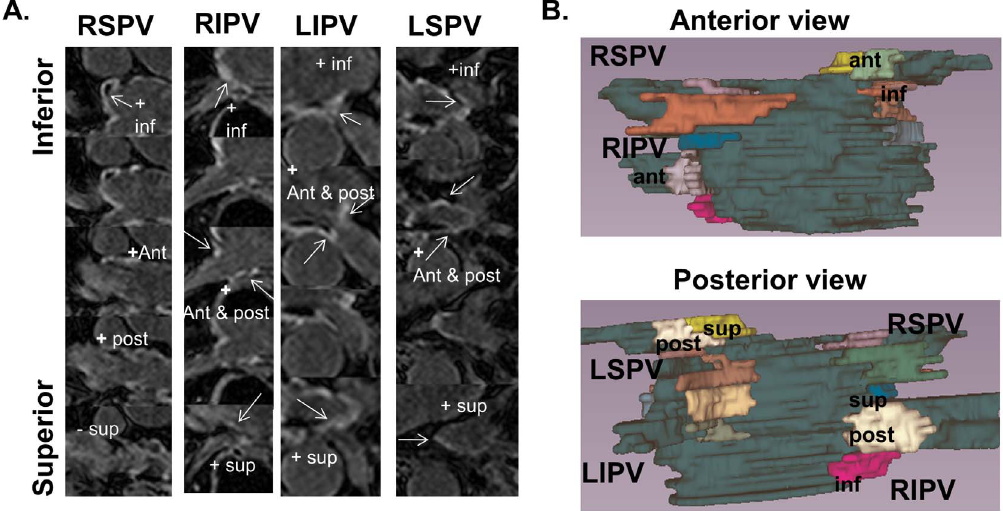
Figure 3. 16 segment model showing the 4 regions evaluated around each pulmonary vein. A) Zoomed and cropped slices labeled by region. B) 3D color-coded display, showing 4 regions about each PV, with explicit labeling for the right inferior and left superior PV.